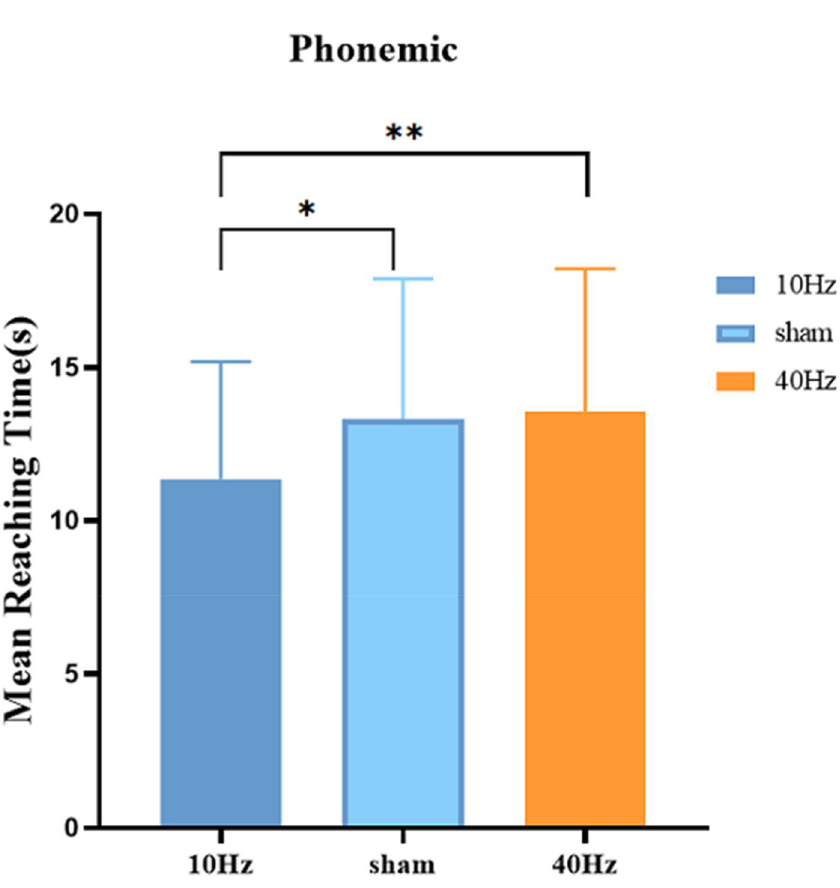
Figure 5. The time required for subjects to reach the fifth word. Mean reaching time (average for one consonant) in the phonemic fluency task in the experiment.